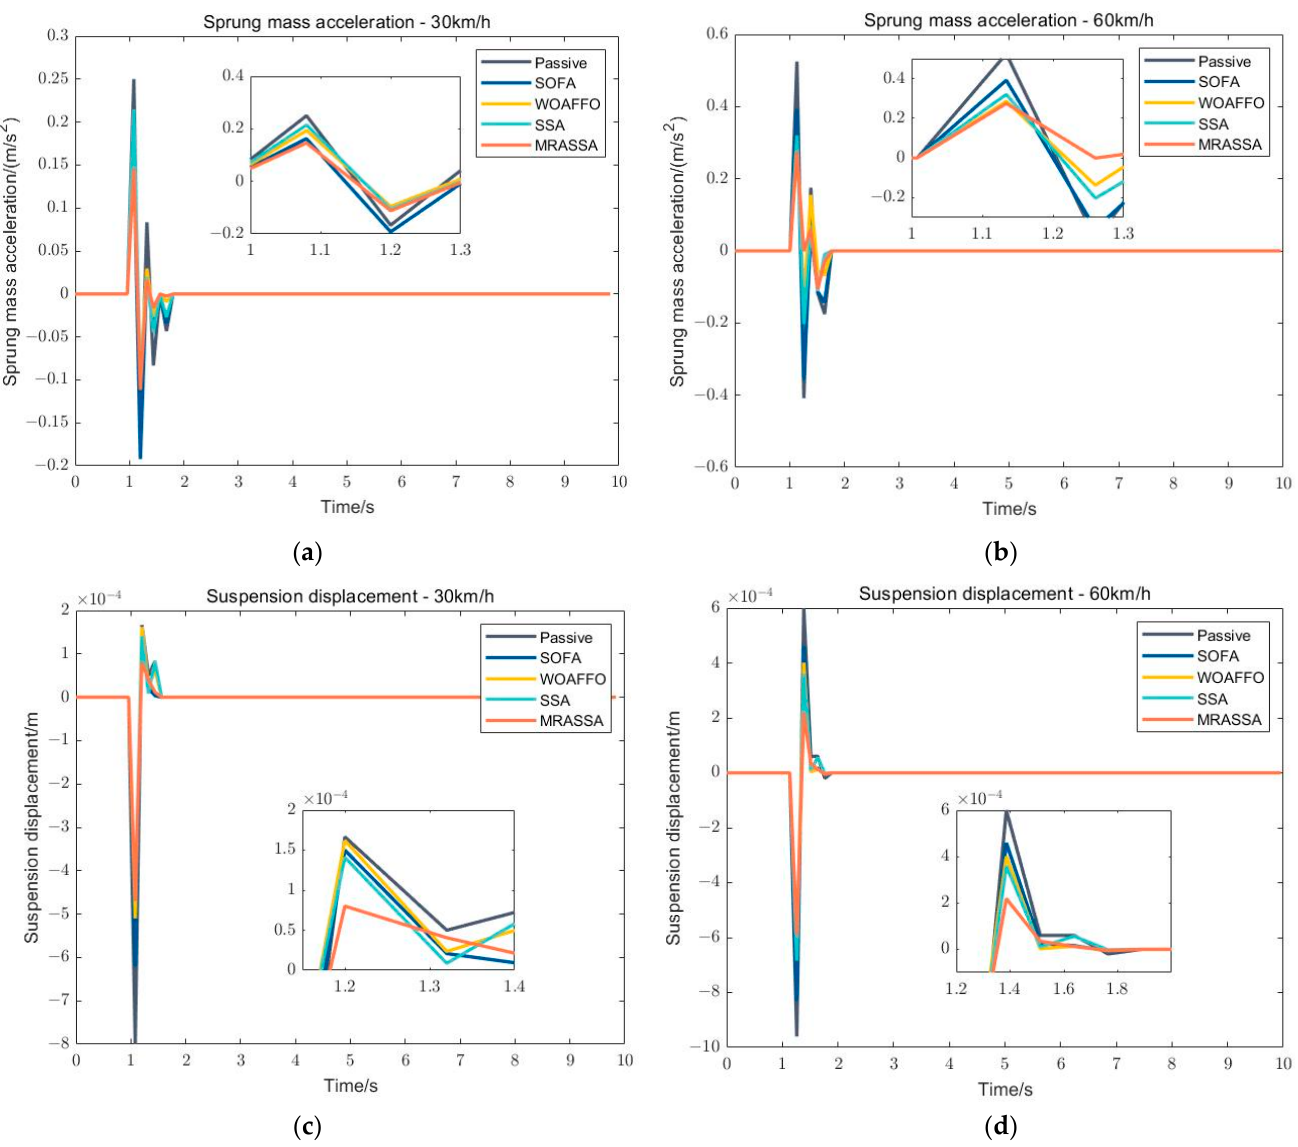
Figure 11. Suspension performance at the single bump in the experimental platform. ( a ) Suspen- sion acceleration at 30 km/h; ( b ) Suspension acceleration at 60 km/h; ( c ) Suspension displacement at 30 km/h; ( d ) Suspension displacement at 60 km/h.